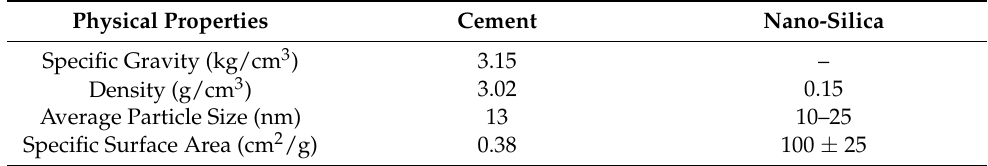
Table 2. Physical properties of cementitious materials.